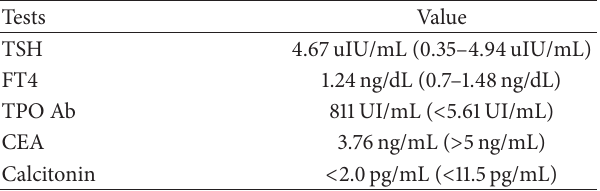
Table 1: Preoperative laboratory findings (serum